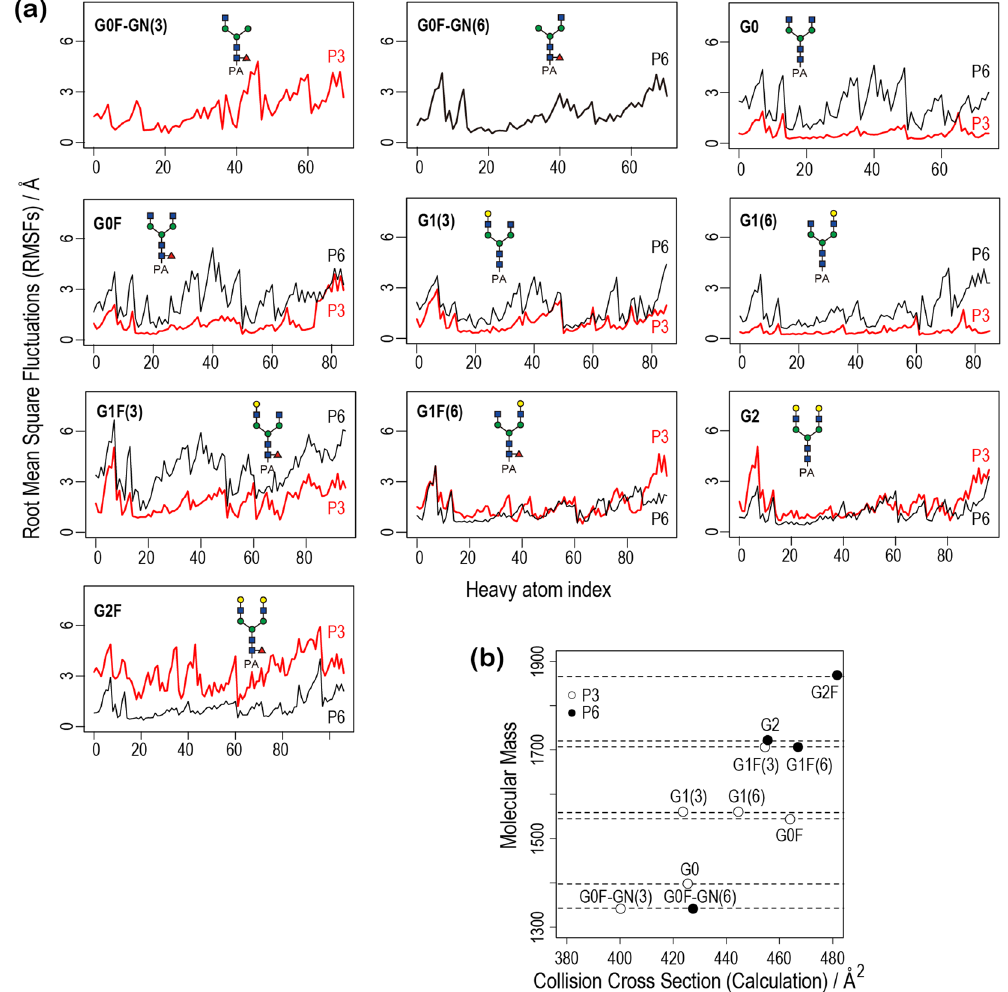
Figure 2. ( a ) RMSFs of heavy atoms calculated for the ten PA-glycans. The protonation states, P3 and P6, are marked using red and black lines, respectively. ( b ) Plot of calculated Collision Cross Sections (CCSs) along molecular mass. P3 and P6 indicate the different protonation states (P3: H + at α 1-3 (white), P6: H + at α 1-6 branch